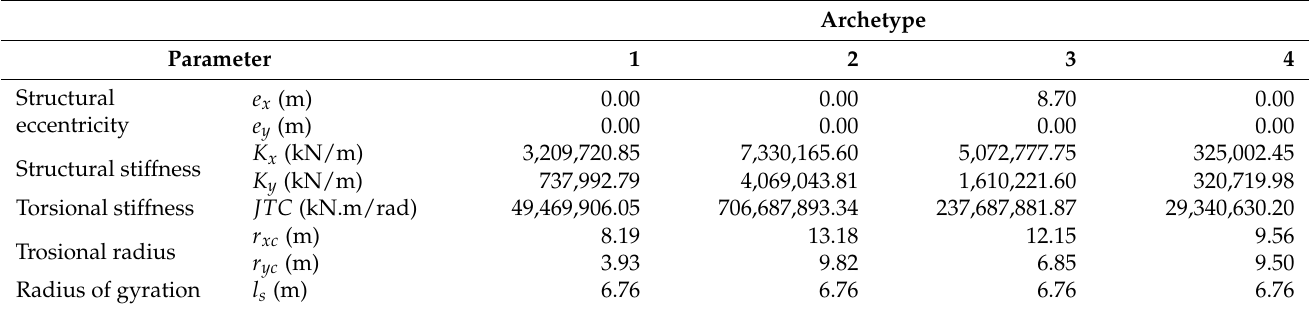
Table 4. Torsional properties of the archetypes.